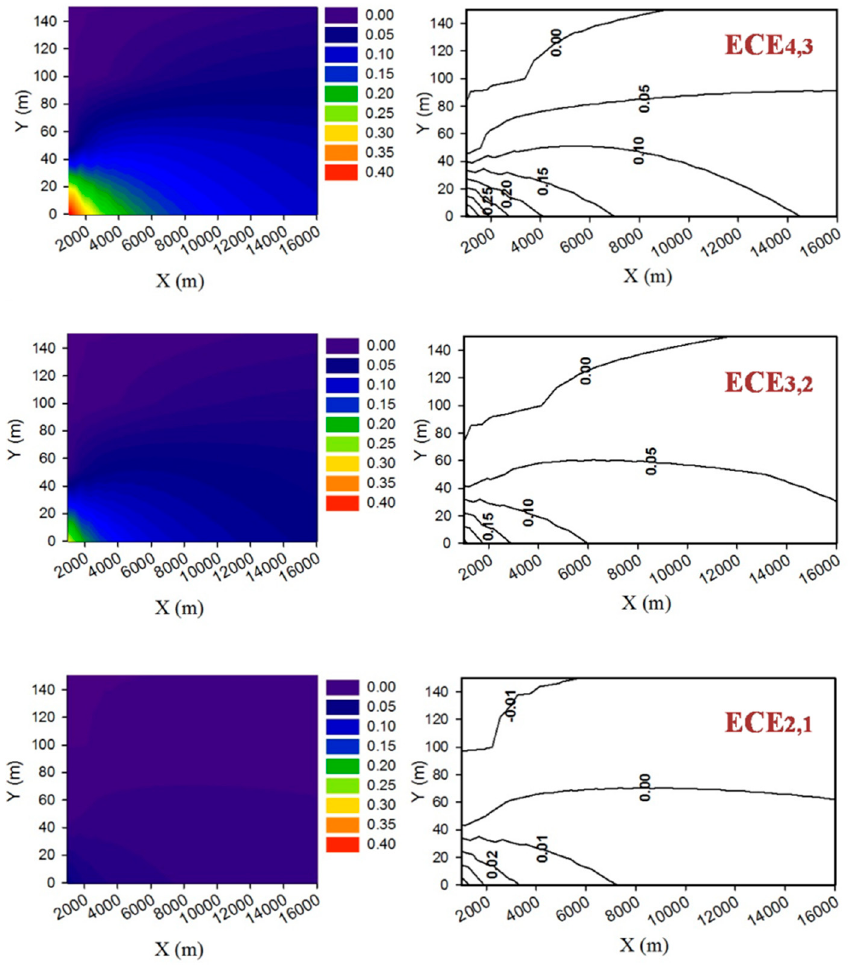
Figure 3. Estimation of ECE results within different river areas (x, y).